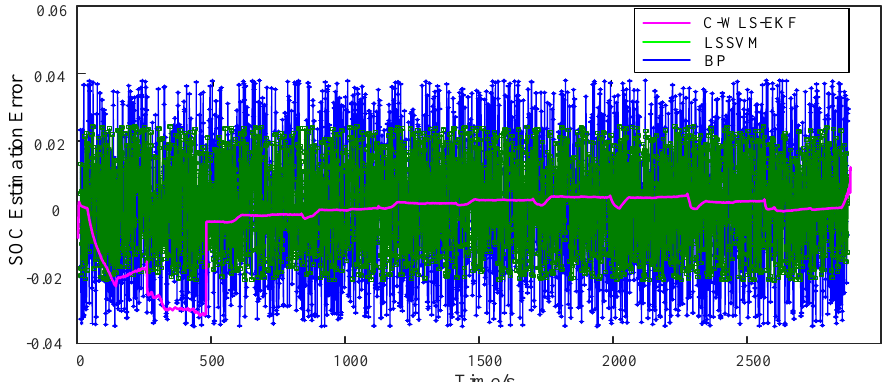
Figure 13. Estimation error distribution of the C-WLS-EKF and intelligent algorithm.